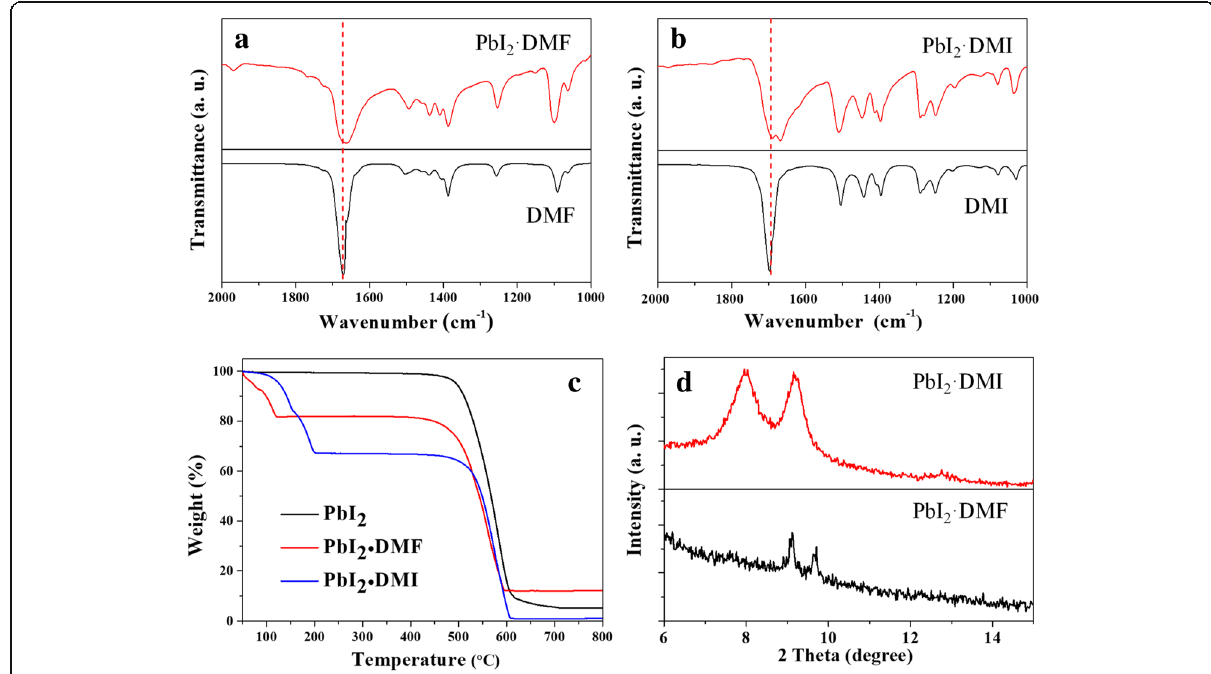
Fig. 1 a Fourier transform infrared transmittance spectra of DMF and PbI 2 ∙ DMF. b Fourier transform infrared transmittance spectra of DMI and PbI 2 ∙ DMI. c Thermal gravimetric analysis of the PbI 2 Lewis adducts. d XRD curves of the Lewis adducts of PbI 2 ∙ DMI and PbI 2 ∙